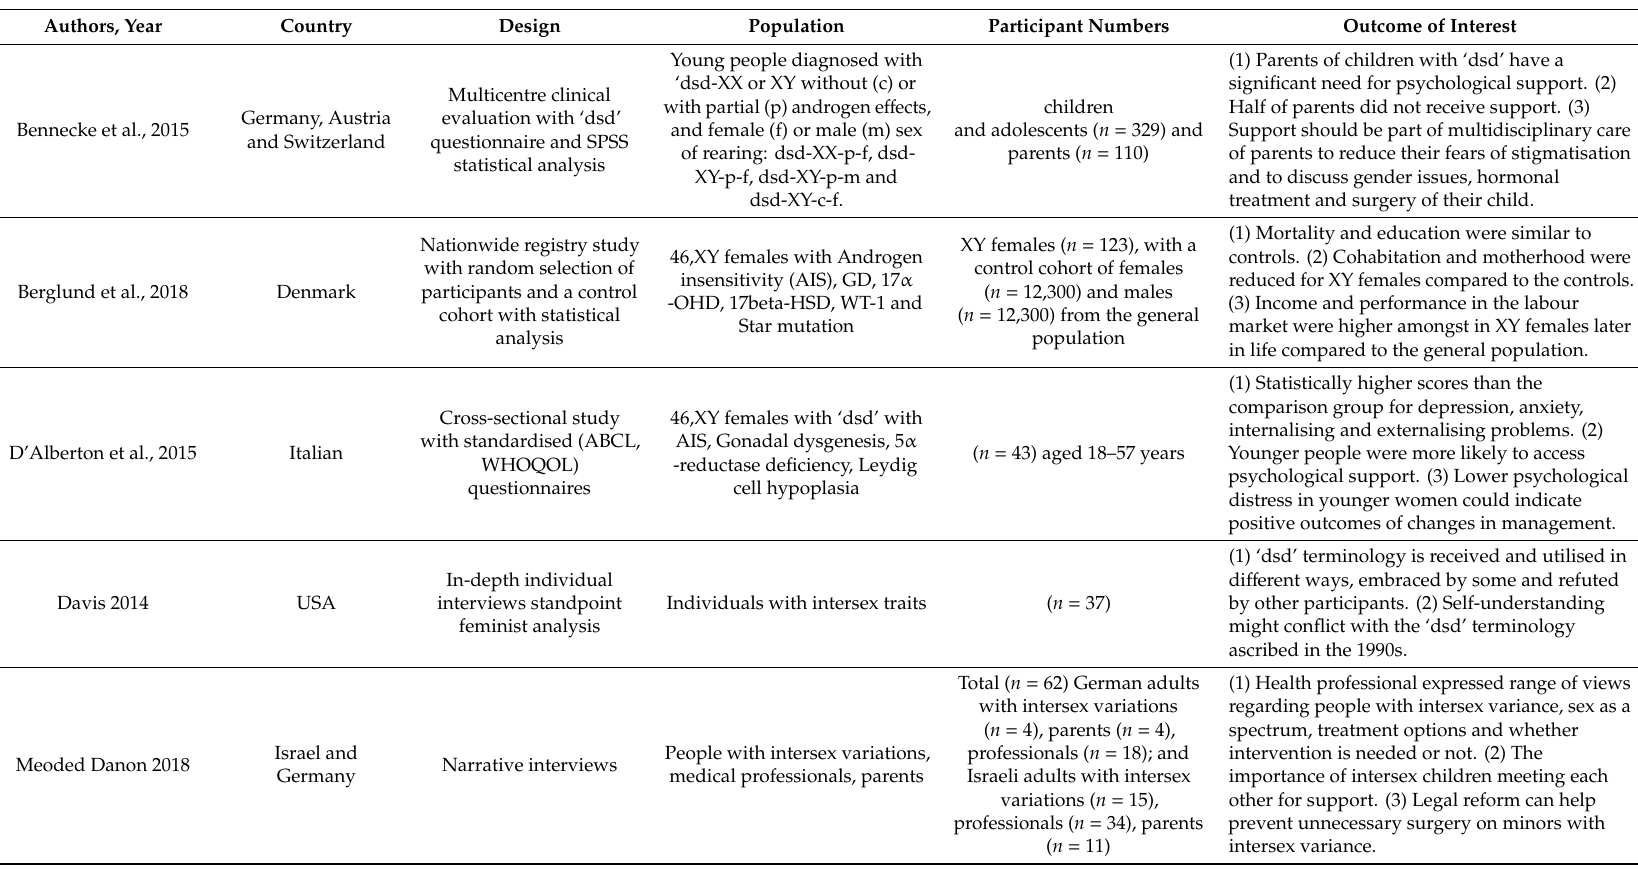
Table 1. Characteristics of included